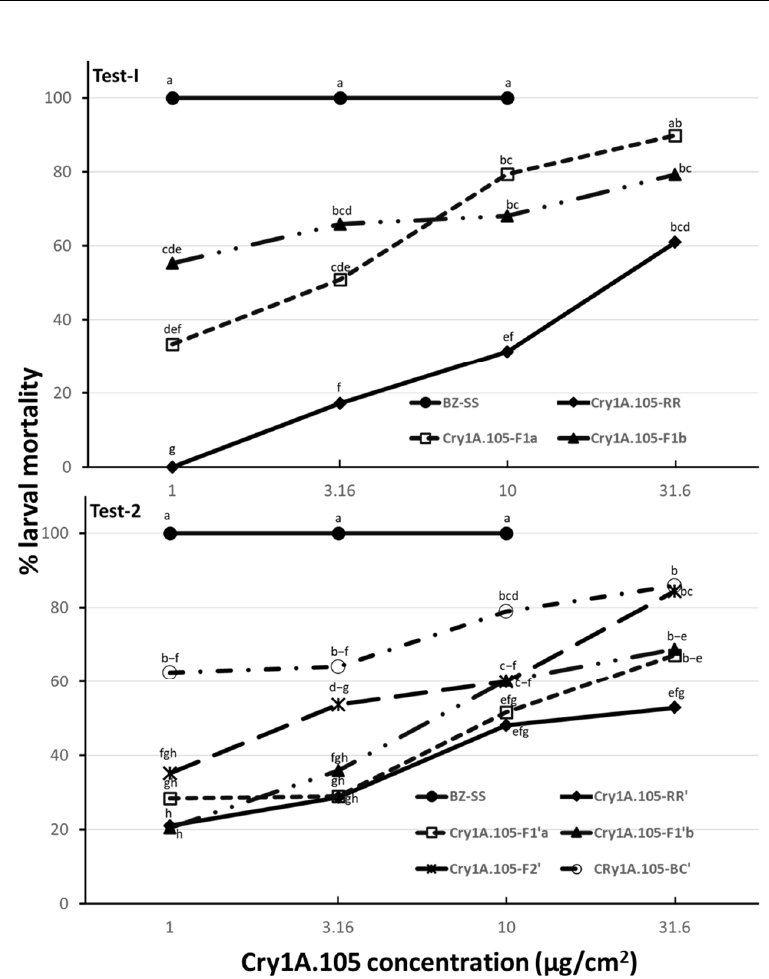
four discriminating concentrations and for both Test-I and Test-II (Figure 1 and Table S1).